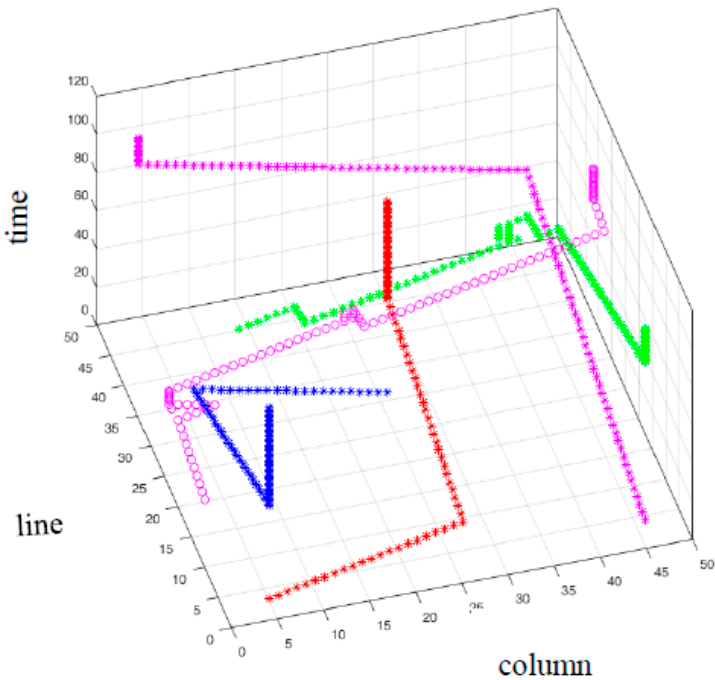
Figure 26. The path of the five microparts in (cid:1846) (time space) with the use of the Equation (13).